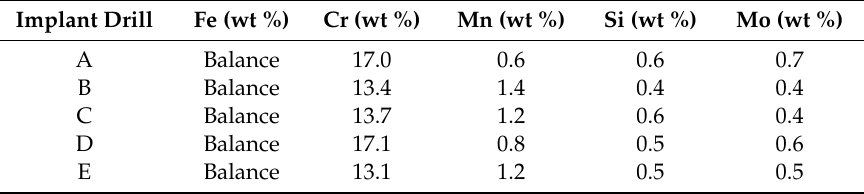
Table 1. Chemical composition of the di ff erent dental implant drills examined. Implant Drill Fe (wt %) Cr (wt %) Mn (wt %) Si (wt %) Mo (wt %)